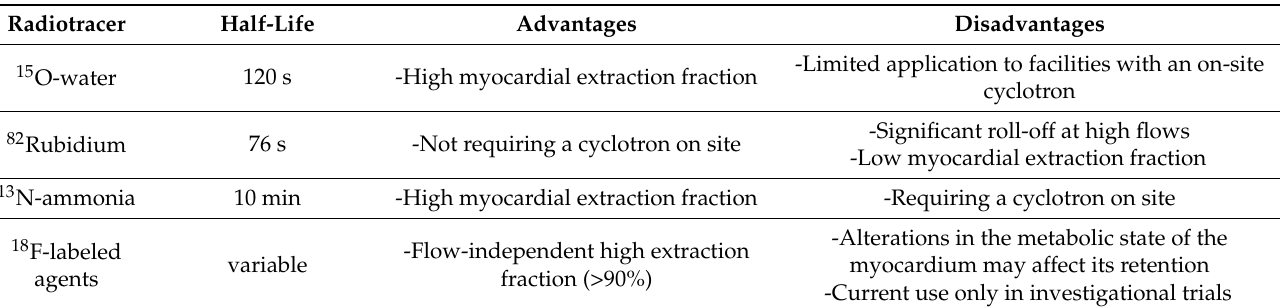
Table 2. Characteristics of the main PET